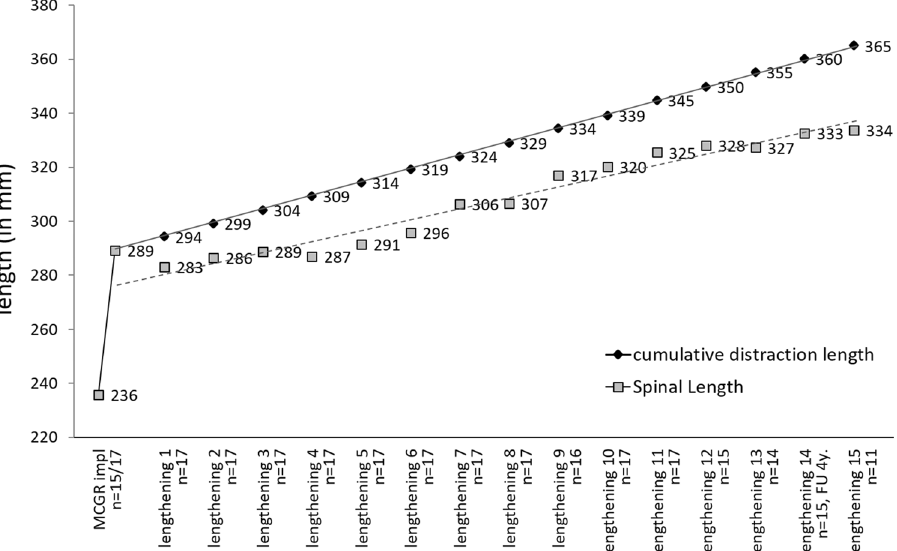
Figure 5. Development of the spinal length (grey; mean, in mm) and the cumulative distraction length (black; mean, in mm) before and after MCGR implantation and after lengthening procedures. The regression lines are drawn for all values post